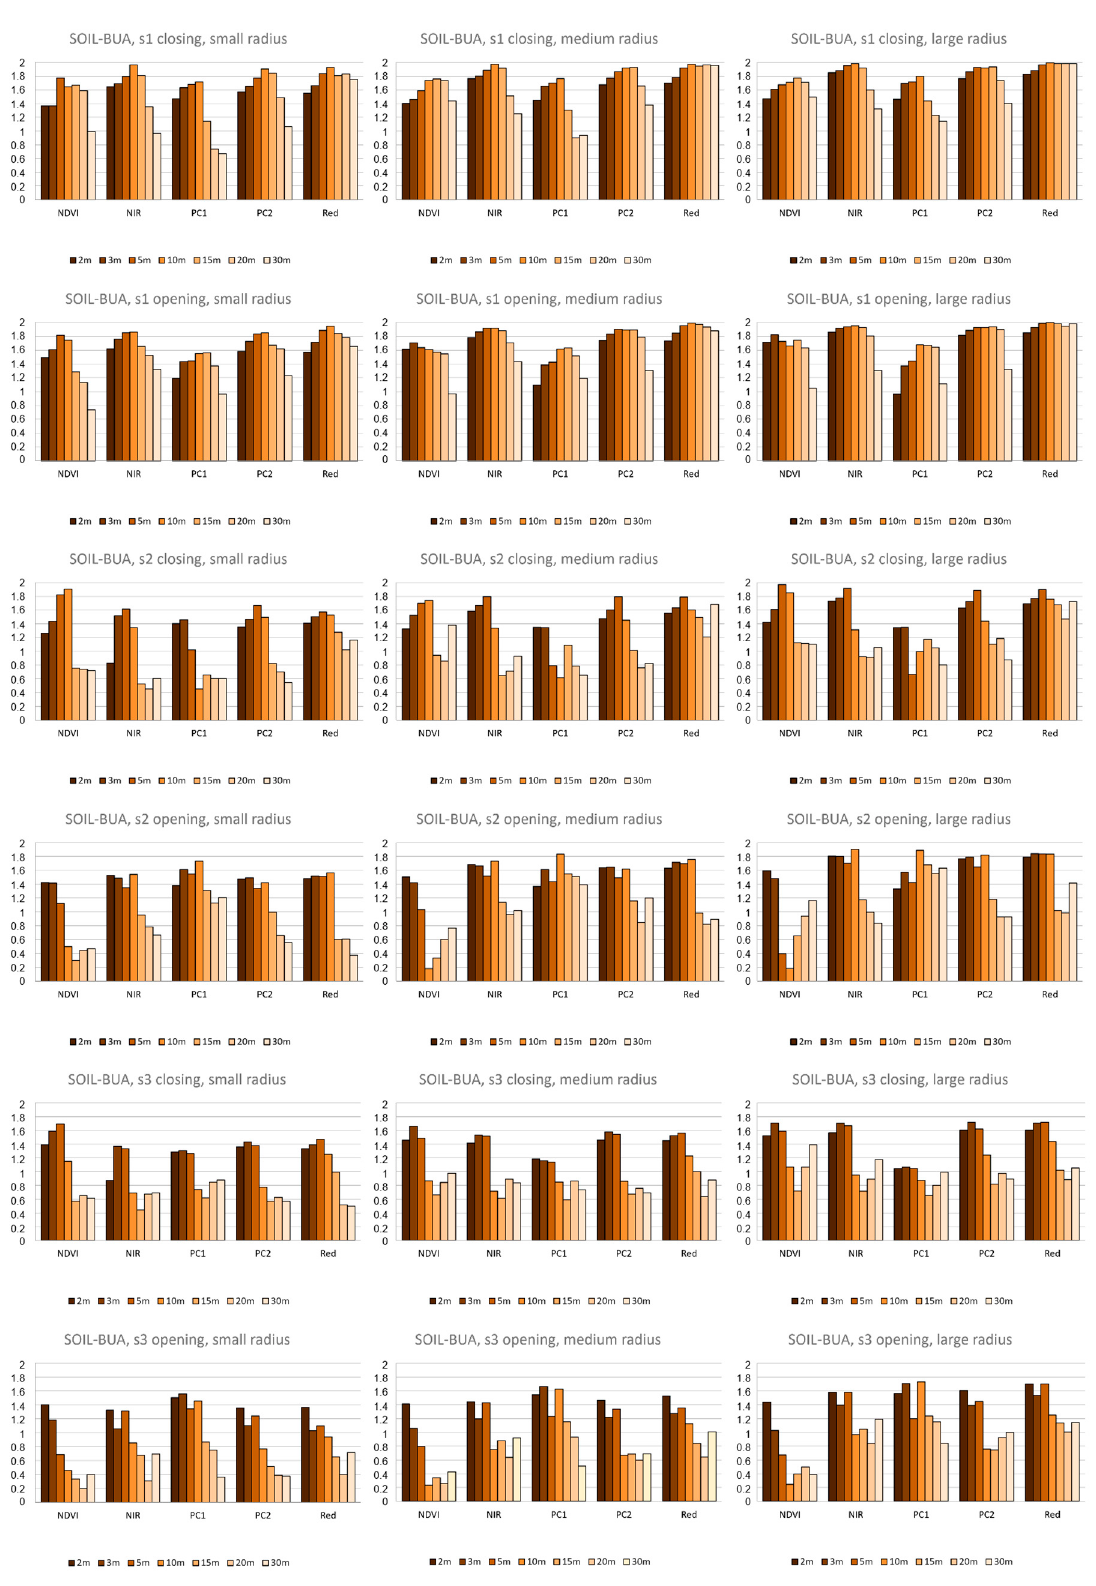
Figure 8. J–M distance diagrams for test fields for the bare soil/built-up area pair (SOIL/BUA).